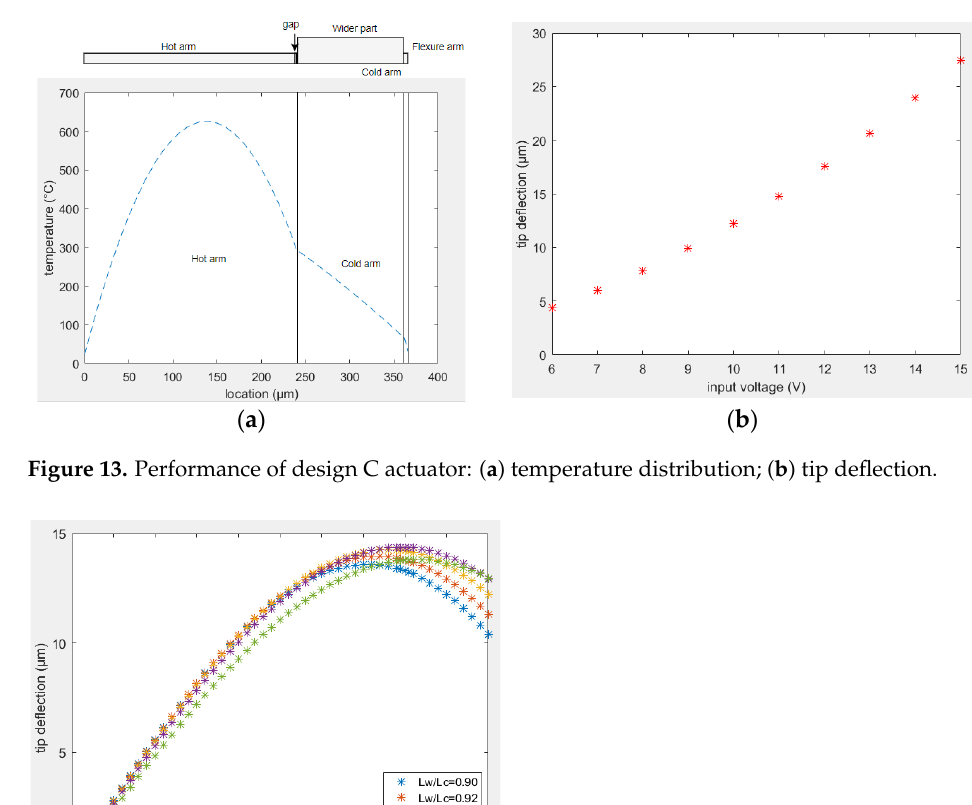
10 of 19 Figure 12. Schematic diagram of design C.